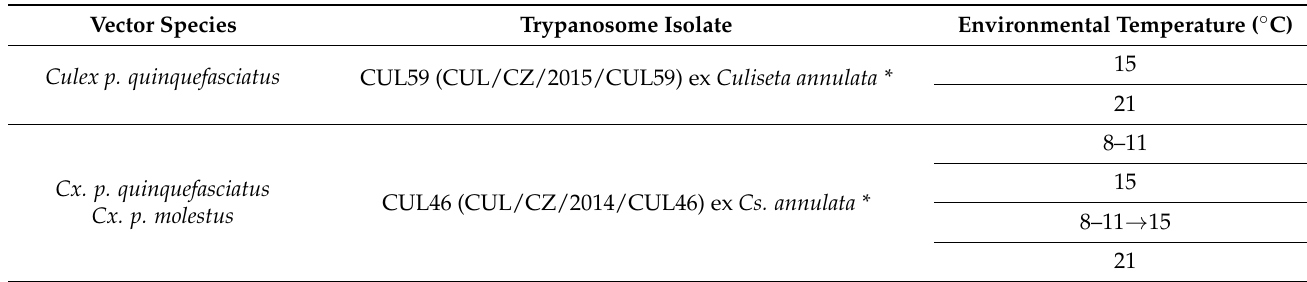
Table 1. Vector species, trypanosome isolates, and environmental temperatures used in the infectious the 21st day, they were held at 15 ◦